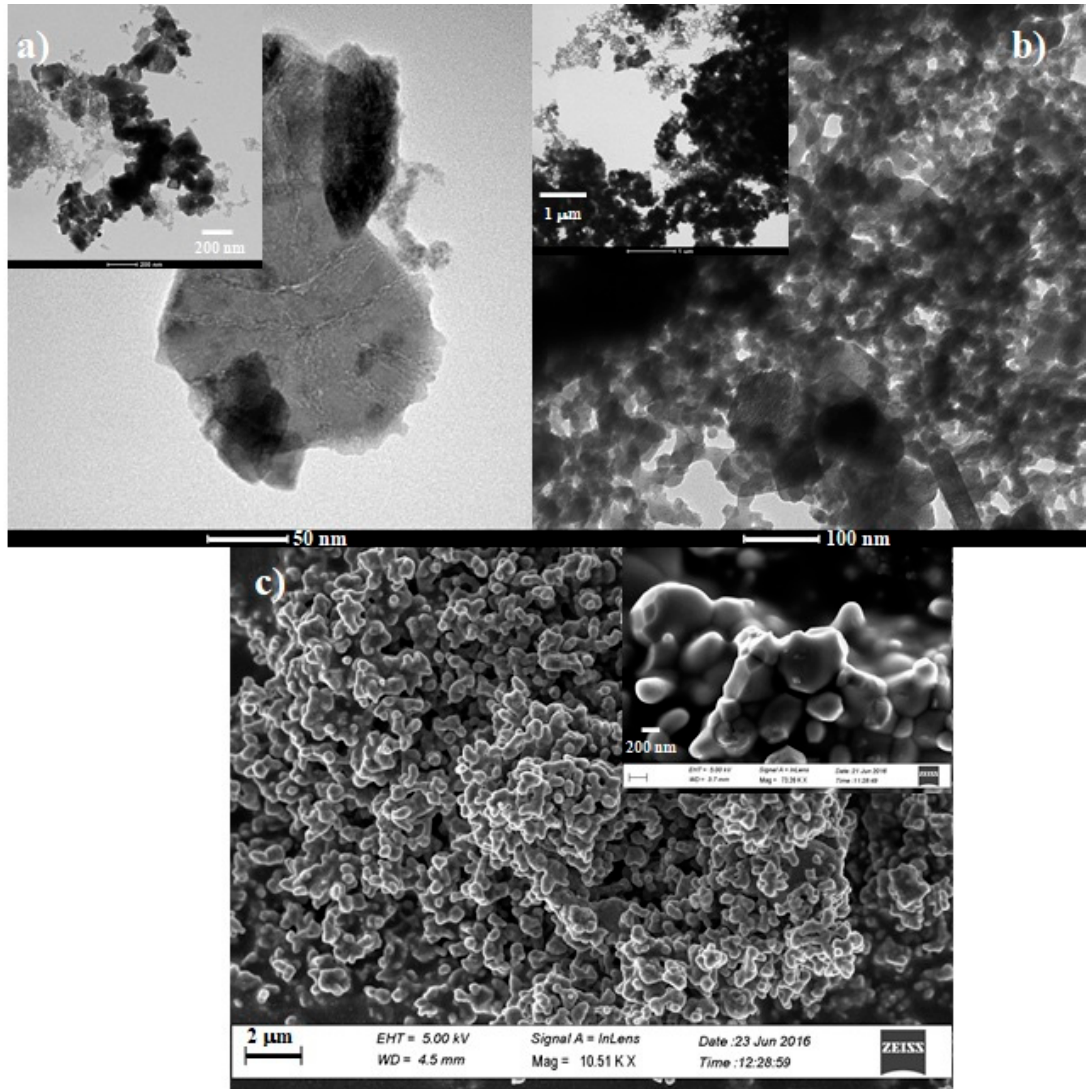
Figure 7. TEM images of ( a ) Fe 3 O 4 / 0.6CeO 2 , ( b ) Fe 3 O 4 / 1.5CeO 2 . ( c ) FESEM image of Fe 3 O 4 / 1.5CeO 2 calcined at 1000 °C.